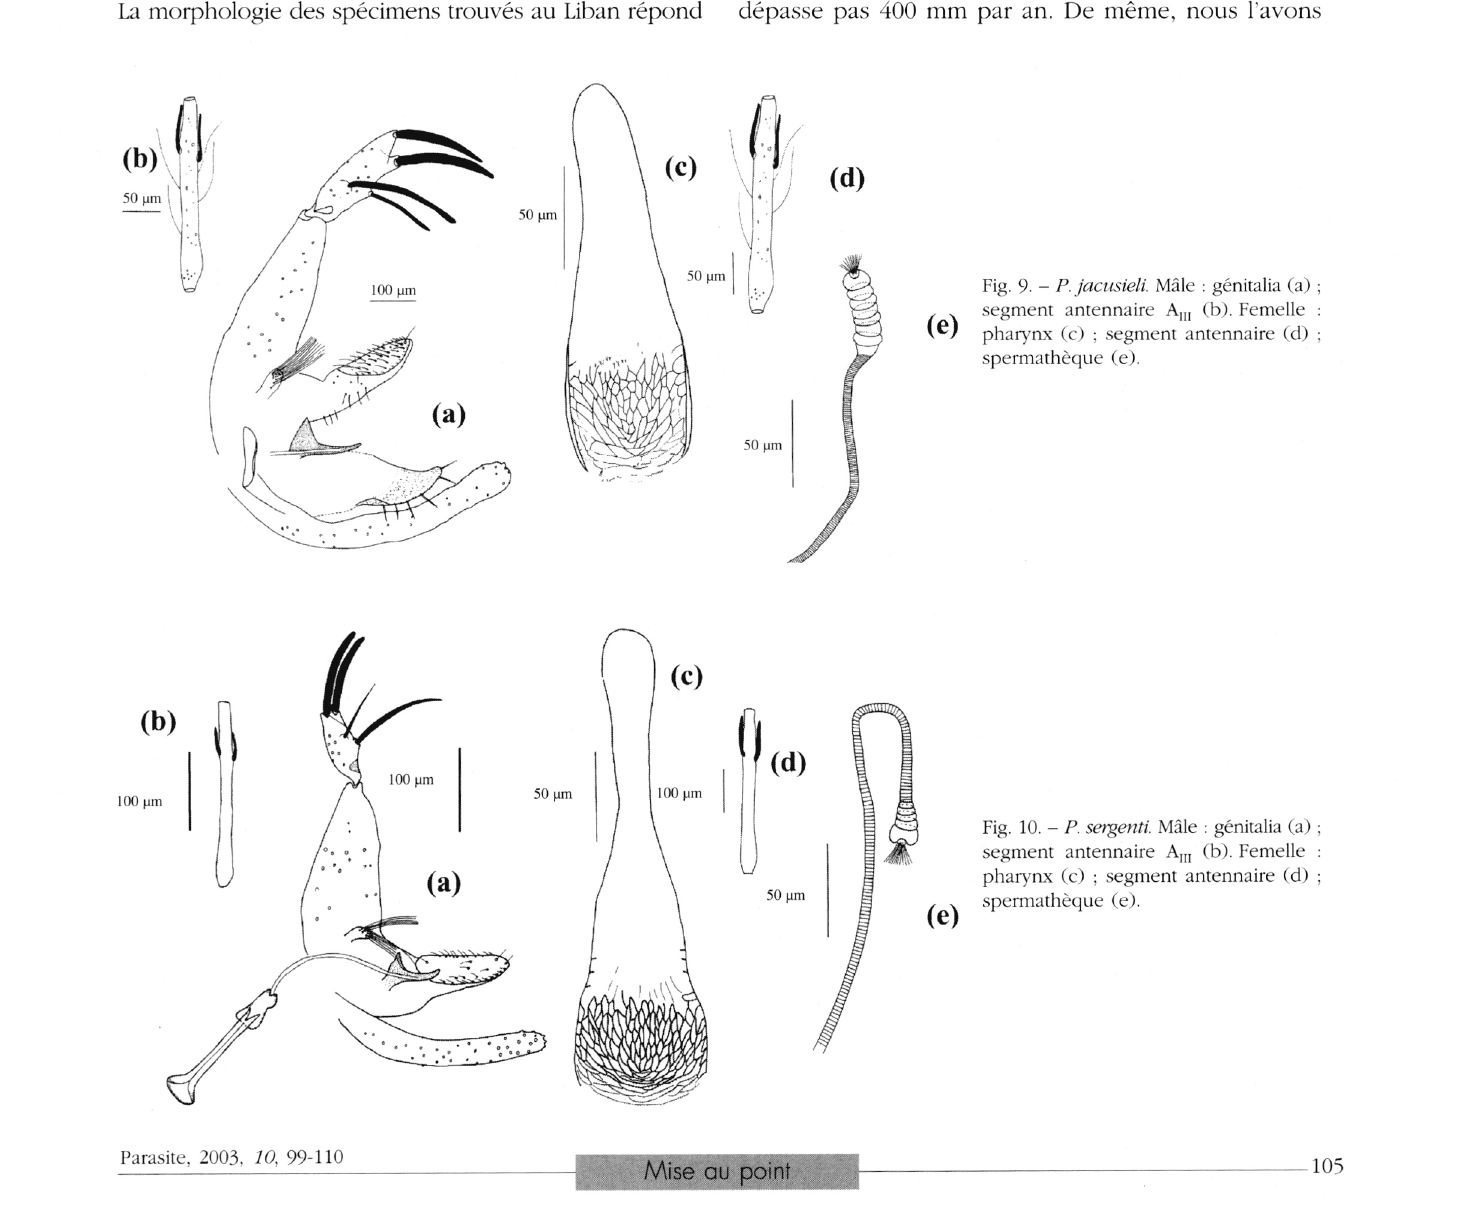
Fig. 10. - P. sergenti. Mâle : génitalia (a) ; segment antennaire AIII (b). Femelle : pharynx (c) ; segment antennaire (d) ; spermathèque